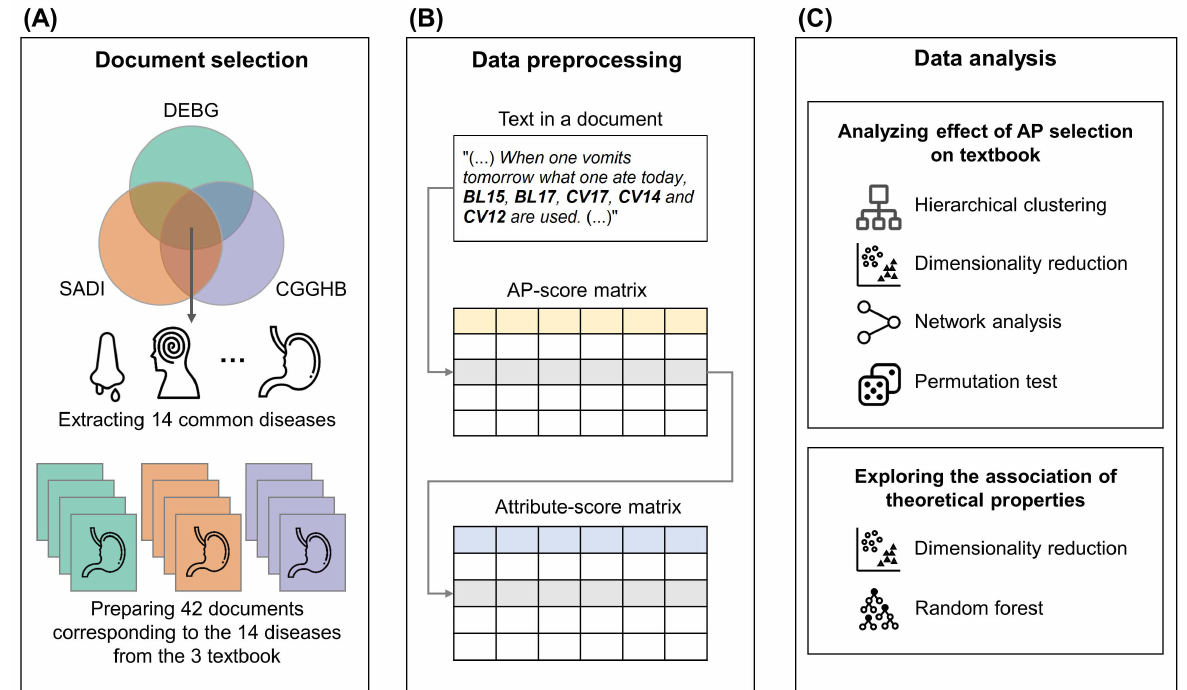
Figure 1. Study protocol. ( A ) Fourteen common diseases in three textbooks, DEBG, SADI, and CGGHB, were selected. For each textbook, 14 documents corresponding to the diseases were selected. ( B ) Texts, including AP prescriptions in each document, were transformed into AP-scores and AP attribute-scores. An AP-score matrix and an AP attribute-score matrix were constructed using the AP-scores and AP attribute-scores of the AP prescriptions. The rows of matrices represent the AP prescriptions, and the columns represent APs and attributes. ( C ) The effects of textbooks on AP prescriptions and their association with the theoretical attributes of APs were analyzed. AP: Acupuncture point, DEBG: Dongeuibogam , SADI: Saamdoinchimgooyogyeol , CGGHB: Chimgoogyeongheombang